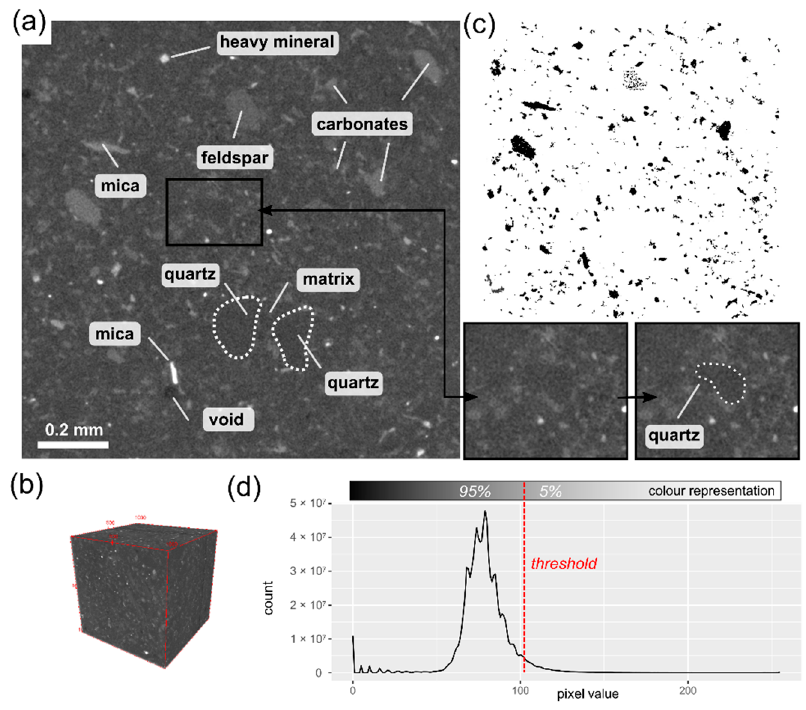
Figure 4. ( a ) Selected micro-CT image of the sample with mineral components marked. Note that outlines of quartz grains are visible; ( b ) 3D visualization of the VOI; ( c ) The extracted and analysed mineral components, the image corresponds to this shown in Figure 4a; ( d ) Histogram of colour distribution (pixel value) within the analysed volume of the sample.